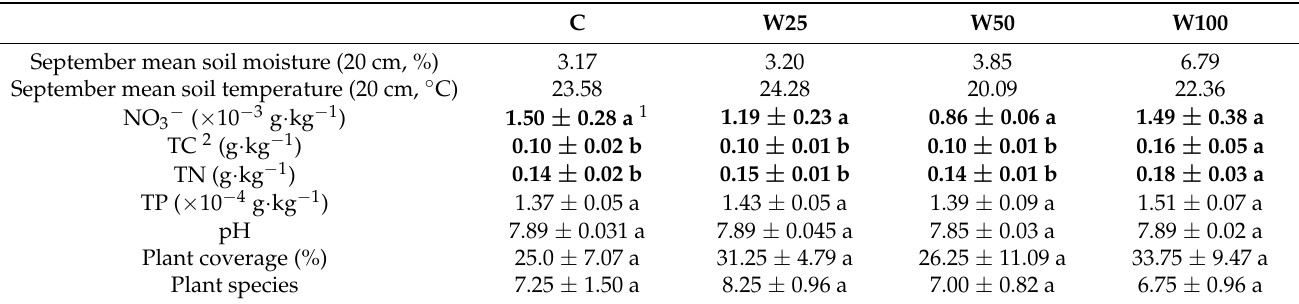
Table 1. Effects of water addition on soil and aboveground plant properties. Values represent mean values and standard deviations ( n =